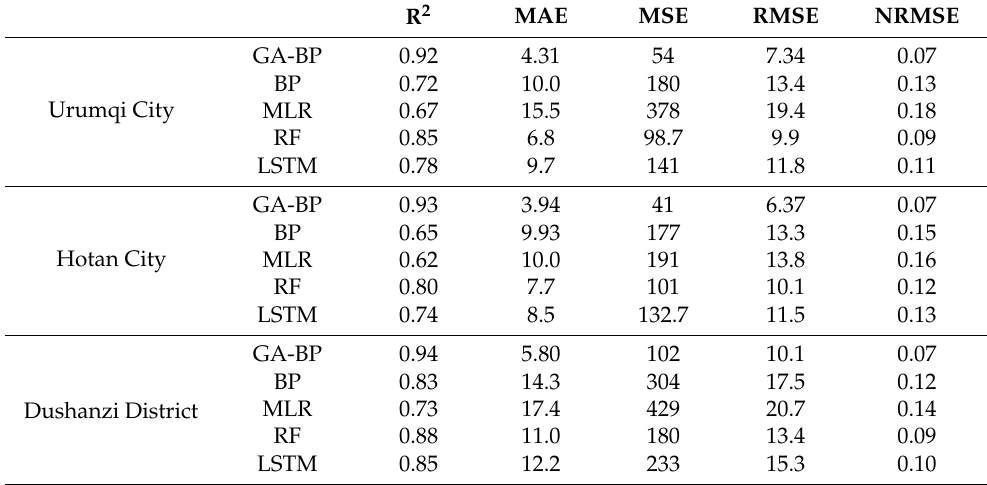
Table 4. Performance metrics of the genetic algorithm optimized artificial neural network (GA-BP) compared with four other simulation methods (BP, MLR, RF, and